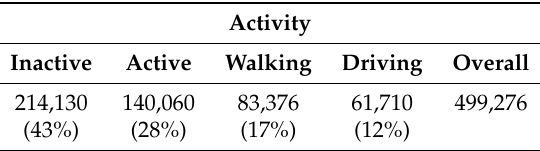
Table 7. Number of patterns for the samples containing all the sensors with a sliding window of 20s and 19s